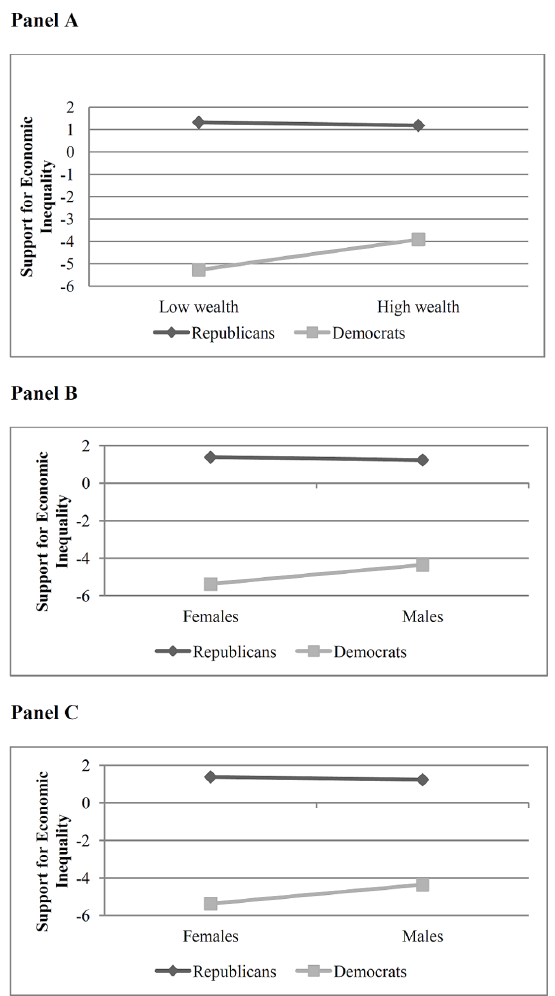
Figure 1. Relationships between social status and the tendency to sponsor legislation supporting economic inequality. Social status is measured in terms of average wealth (Panel A), race (Panel B), and gender (Panel C).